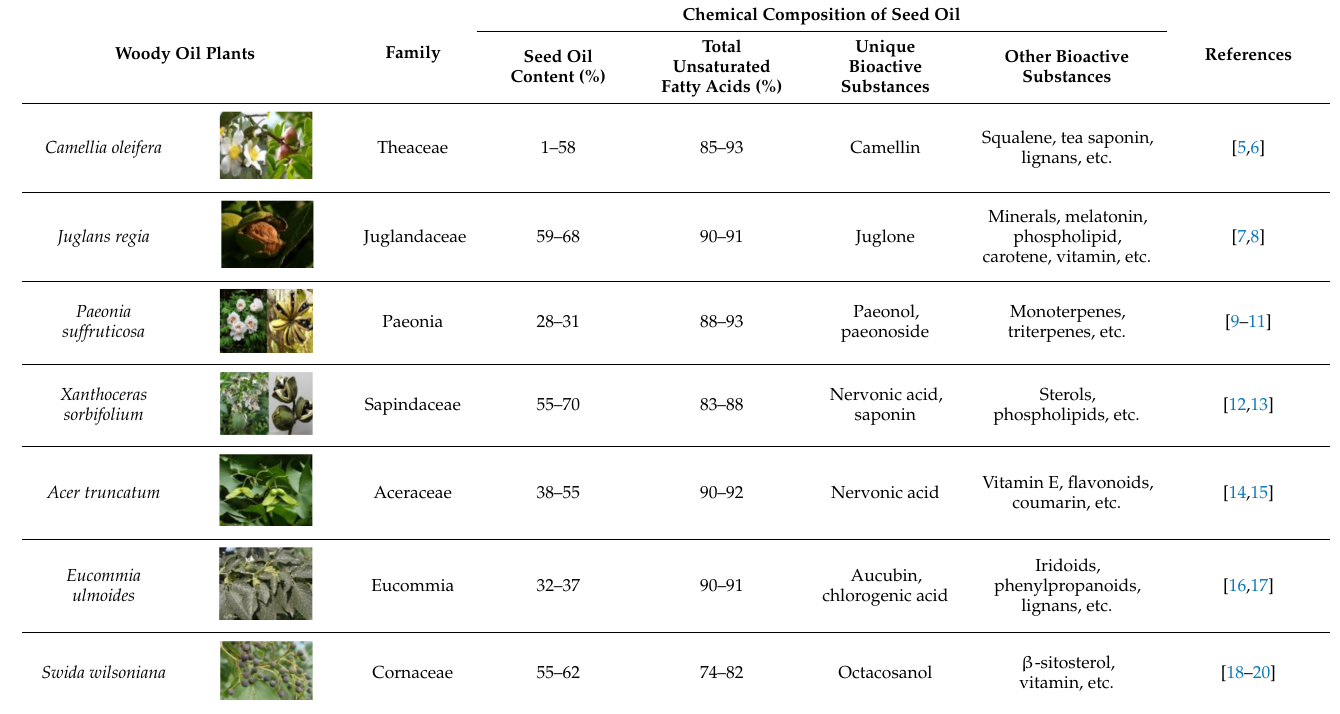
Table 1. Overview of six unique oil crops in